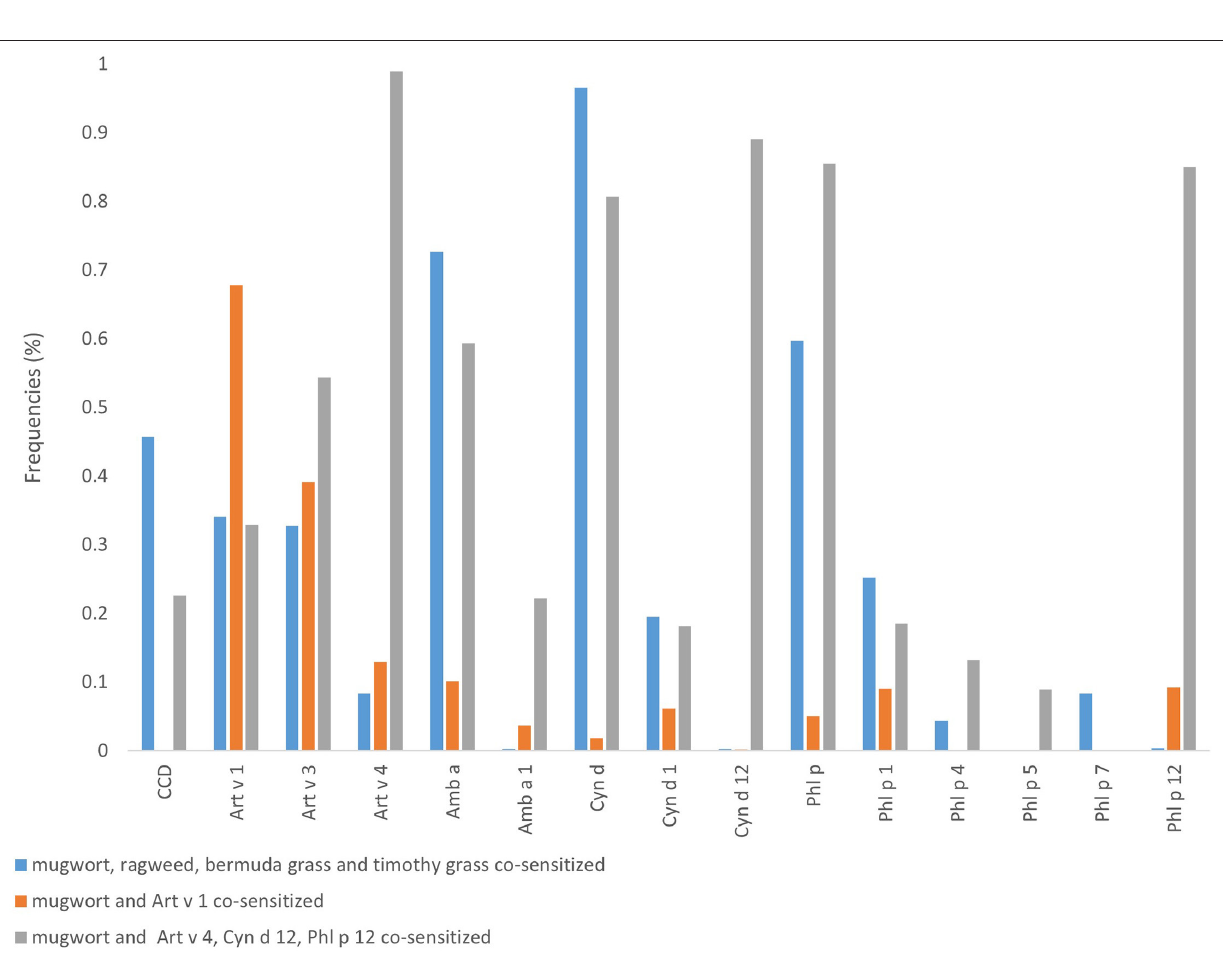
Frontiers in Pediatrics |